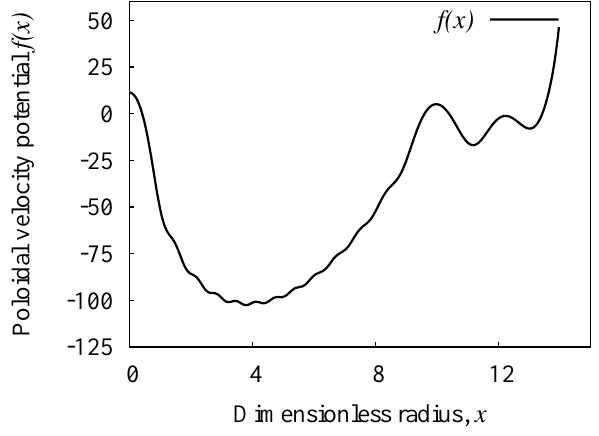
Figure 4. Profile of dimensionless potential field f ( x ) with rotation. The values of parameters are the same as the non-rotational case, Figure 4. Profile of dimentionless potential field f ( x ) with rotation. Figure 2. The best approximation of dimensionless poloidal veloc- except the Coriolis parameter Ω= 0 . 23s − 1 . The values of parameters are the same as the non-rotational case, ity profile f ( x ). The values of the parameters A and a 2 in the Taylor except the Coriolis parameter Ω= 0 . 23s − 1 . expansion (20) correspond to the position of the peak in Fig. 1.